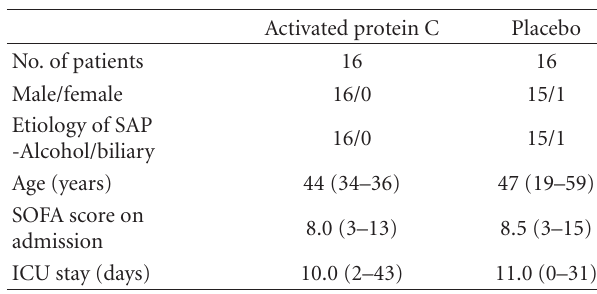
Table 1: Characteristics of patients.